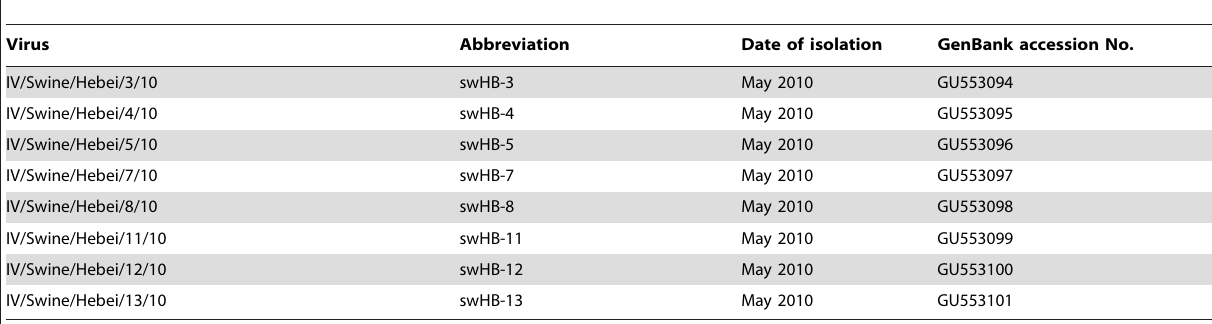
Table 3. Background information of swine HEV examined in this study.